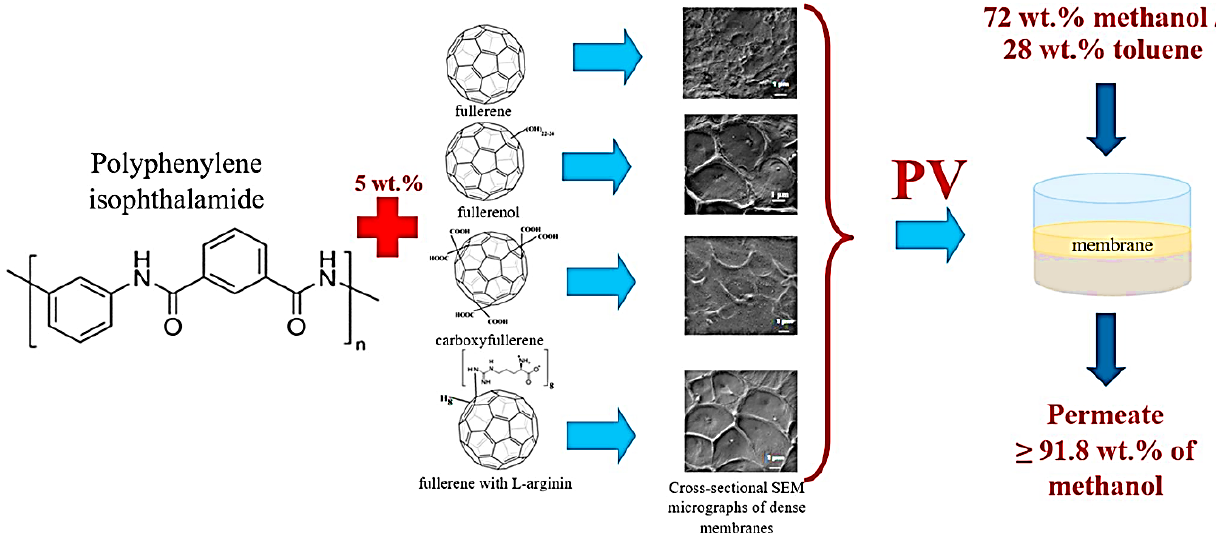
Figure 7. Graphical development of novel polyphenylene isophthalamide pervaporation (PV) mem- branes modified with various types of fullerene C 60 derivatives [166]. Reproduced with permission from Elsevier.